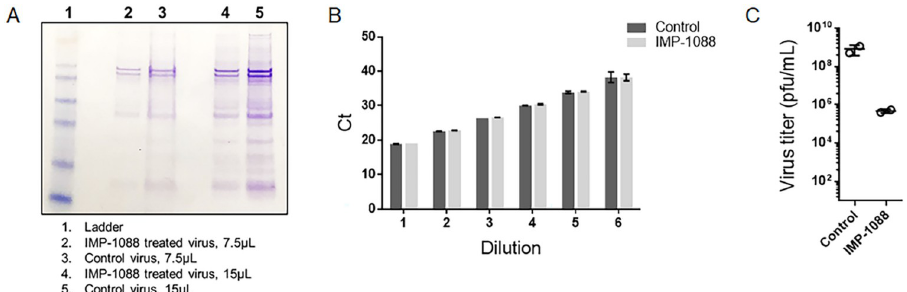
Fig 4. IMP-1088 decreases infectivity of progeny VACV particles. (A) Coomassie stained SDS-PAGE gel showing difference in protein levels between IMP-1088-treated and untreated (control) viruses. BSC-40 cells were infected with VACV WR pE/L-LUC for 24 h in the absence and presence of 2 μ M IMP-1088. Cells were harvested and lysed, and virus particles were purified by sucrose density gradient centrifugation. Either 7.5 or 15 μ l of purified virus was run in a 4–12% SDS PAGE and stained with Coomassie blue. (B) Equivalent viral particles based on Coomassie staining were subjected to DNA isolation followed by real time PCR using VACV-specific primers. Ct values at different dilutions of purified DNA from the two treatments are shown. Data analyzed using Multiple t tests and statistical significance determined using the Holm-Sidak method, with alpha = 5%. For all 6 dilutions, p > 0.05 (C) Equivalent viral particles from untreated and IMP-1088 treated virus were tested by plaque assay to determine virus yields. Yields plotted for both treatments as pfu/mL. Statistical significance determined using an unpaired t test; p >